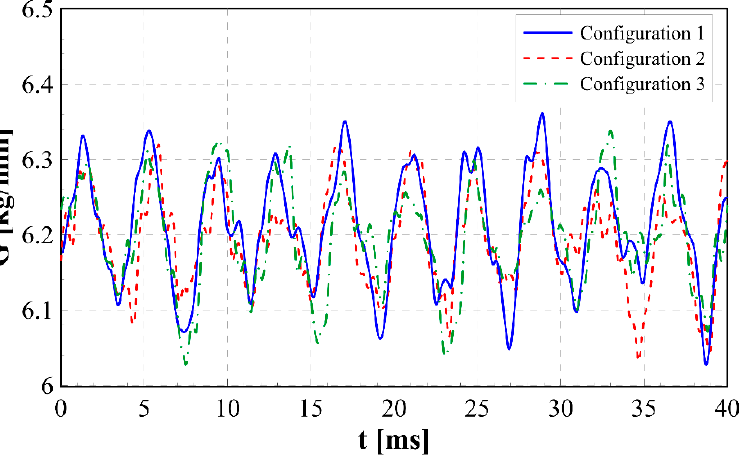
Figure 13. Comparison between experimental flowrates measured with different flowmeter configurations for the same working condition (1200 rpm, 4 bar).